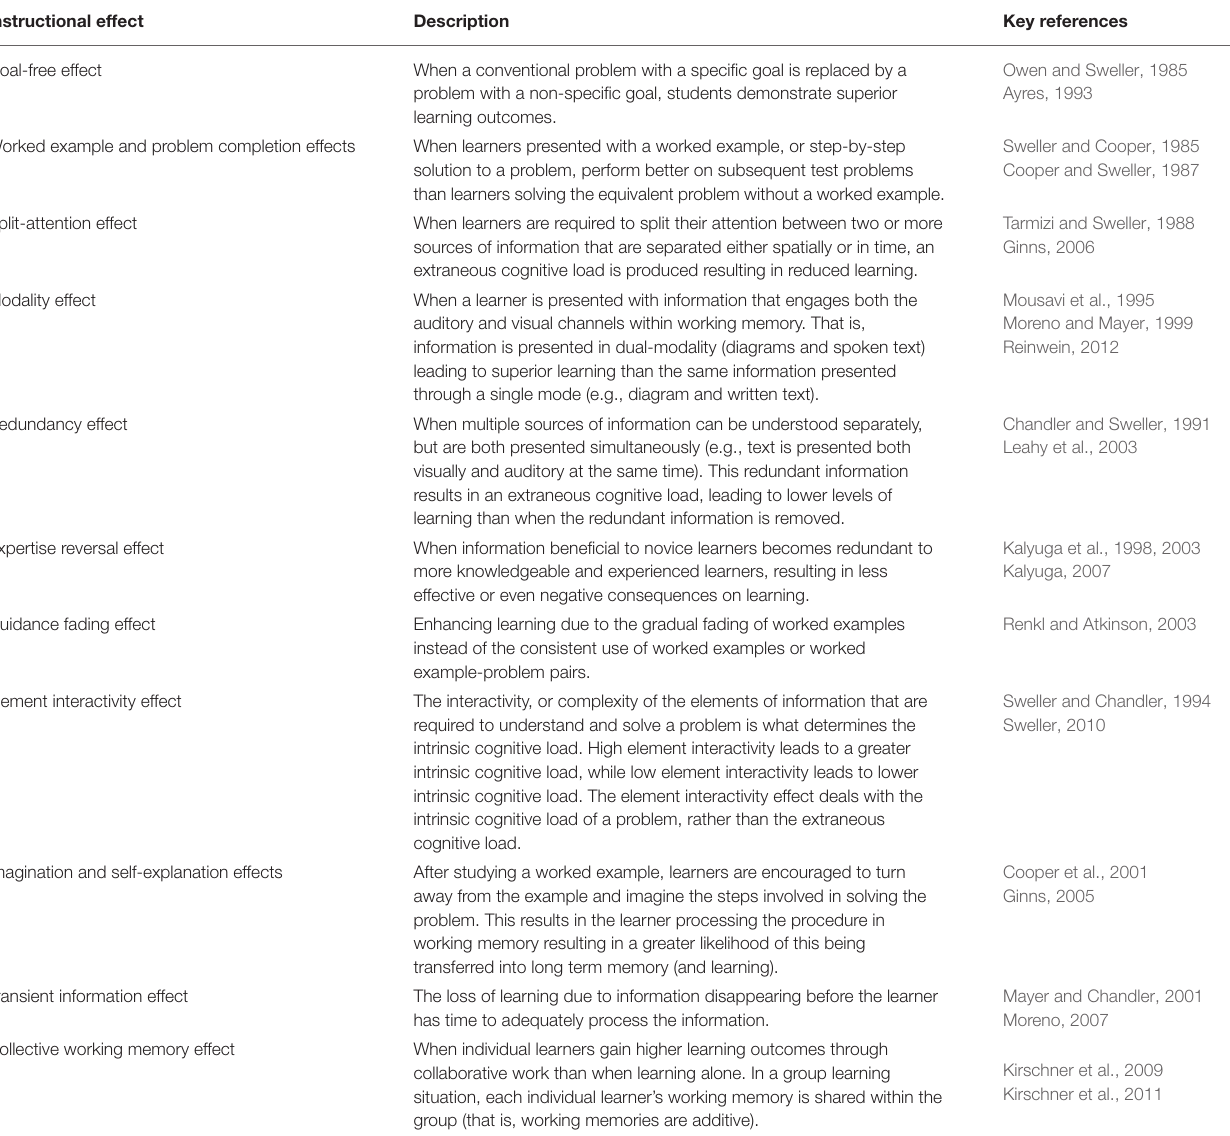
TABLE 1 | Cognitive load theory instructional